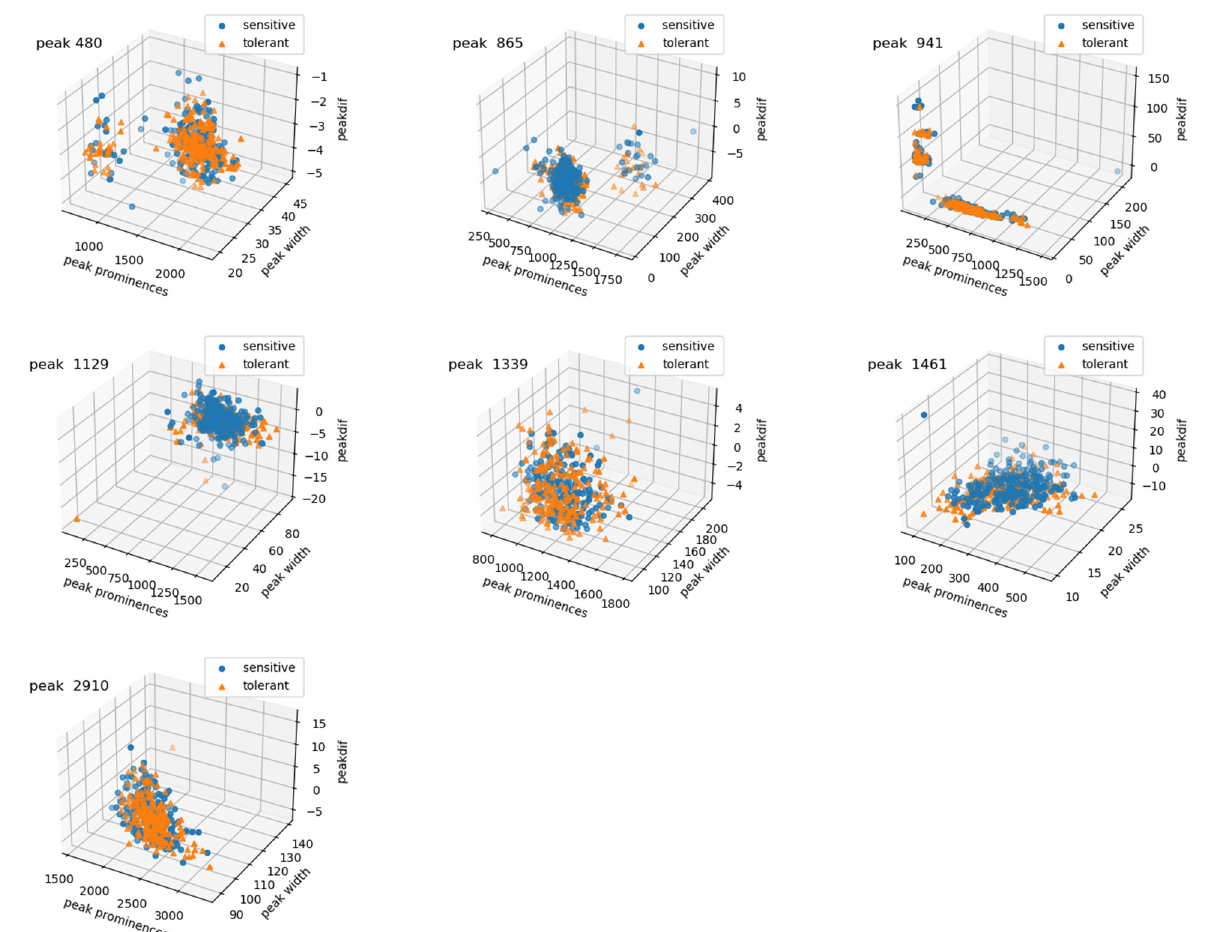
Figure 5. The sample 3D characteristic distribution of 7 wave crests at 480 cm − 1 , 865 cm − 1 , 941 cm − 1 , 1129 cm − 1 , 1339 cm − 1 , 1461 cm − 1 , and 2910 cm − 1 , respectively. Yellow triangles represent samples of saline-alkali-tolerant japonica rice varieties from control and treated fields, blue circles represent samples of saline-alkali-sensitive japonica rice varieties from control and treated fields.